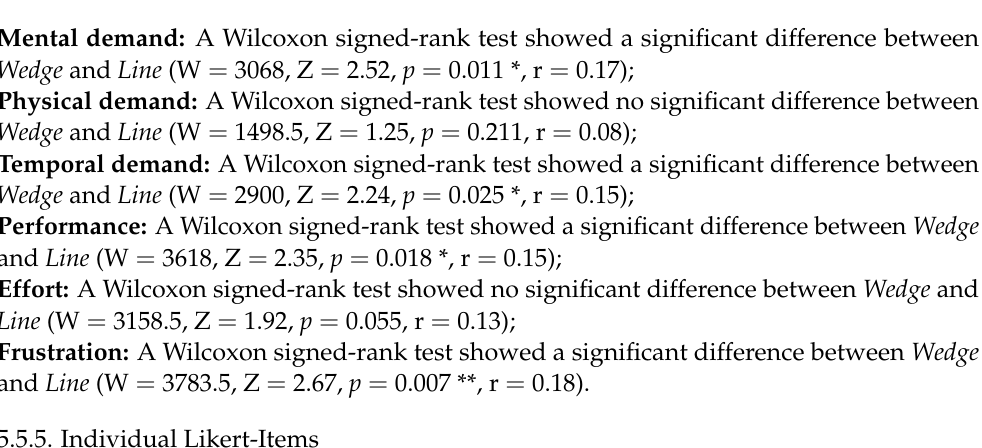
Figure 8. Comparison of task load dimensions for the two different visualization techniques: Wedge and Line